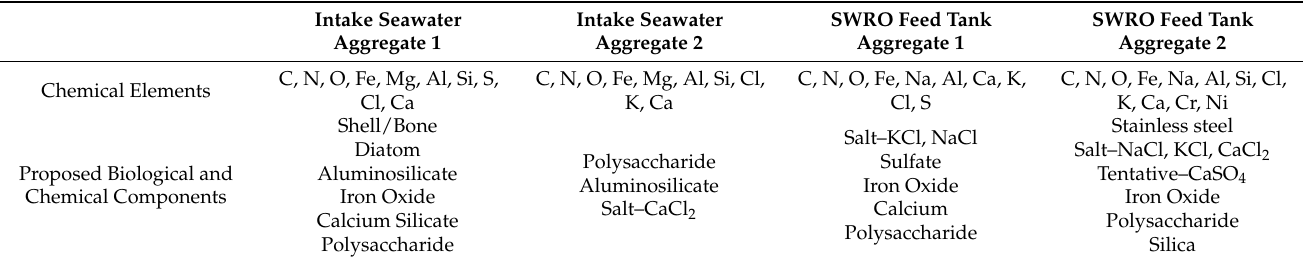
Figure 5. PicoGreen staining of extracellular DNA in the aggregates formed in Penneshaw SWRO desalination plant water. ( A , B ) Aggregates formed in the intake seawater. ( C , D ) Aggregates formed in SWRO feed tank water. Table 2. The elemental composition and proposed biological and chemical components of the aggregates, formed within the Penneshaw SWRO desalination plant intake seawater and SWRO feed tank water, analysed in the present